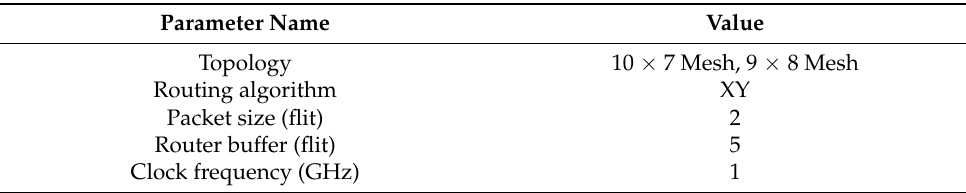
Table 1. The experimental parameters of the NoC architecture.